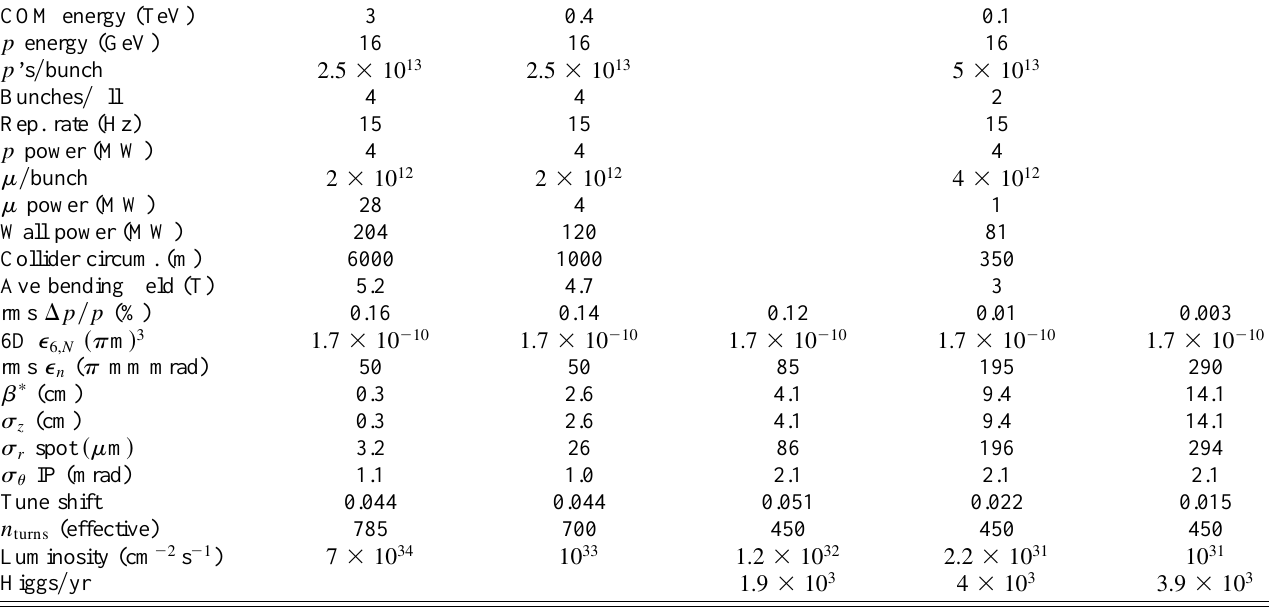
TABLE I. Baseline parameters for high energy and low energy muon colliders. Higgs (cid:1) yr assumes a cross section s (cid:1) 5 3 10 4 fb; a Higgs width G (cid:1) 2.7 MeV, 1 yr (cid:1) 10 7 s.